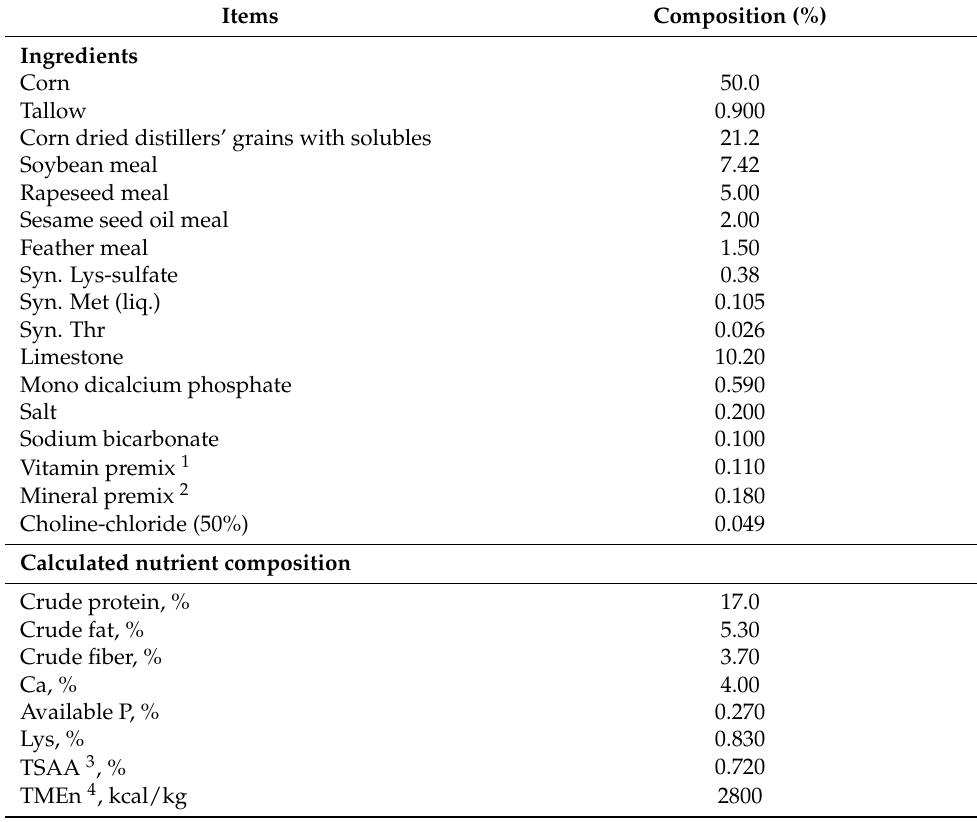
Table 2. Ingredients and nutrient composition of the basal